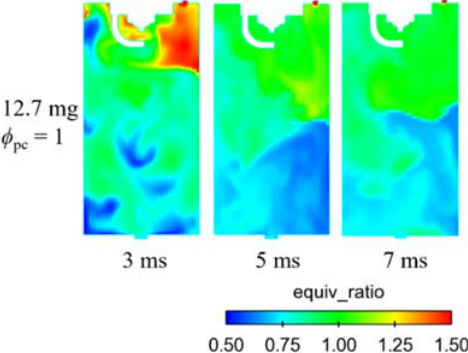
Figure 3. Distribution of equivalence ratio in the prechamber for different spark timings.